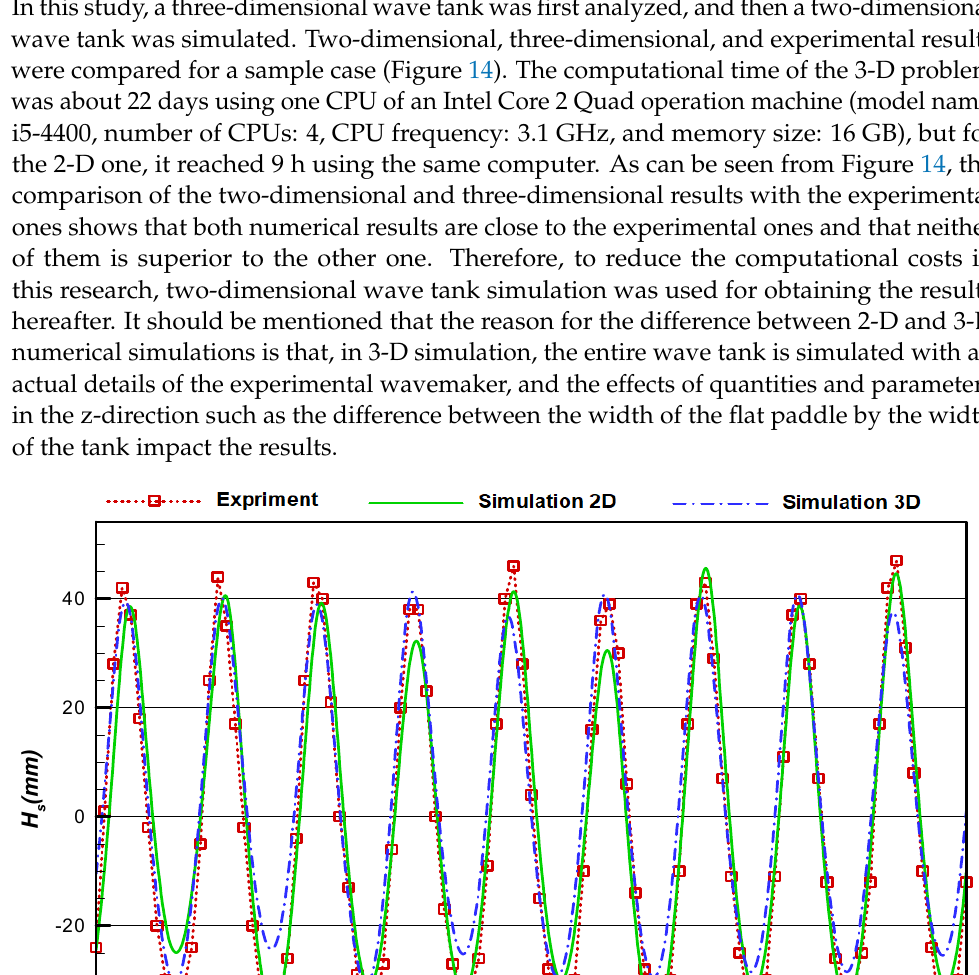
Figure 15. Validation and mesh independence of the simulation.